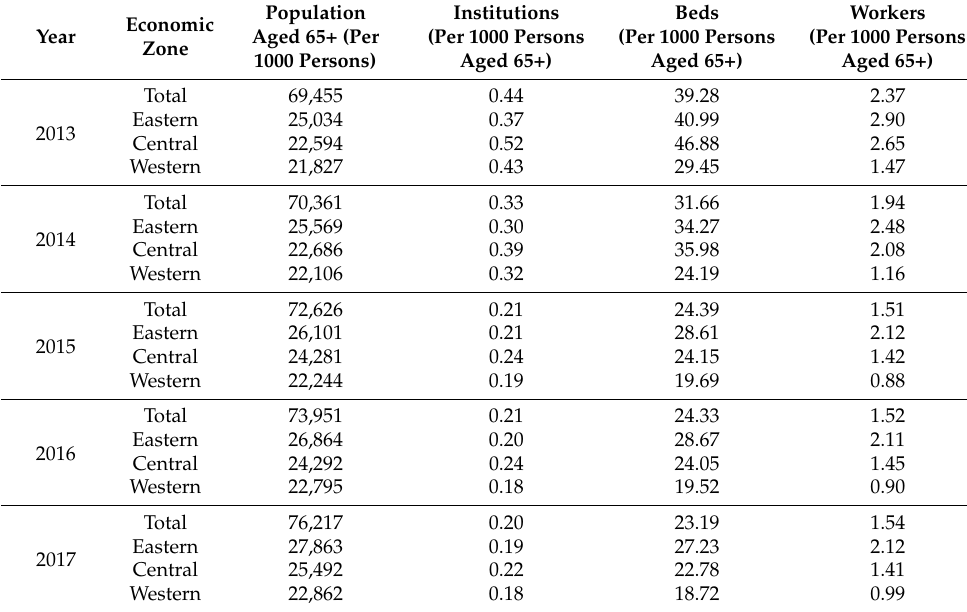
Table 3. LTC resource distribution in rural areas